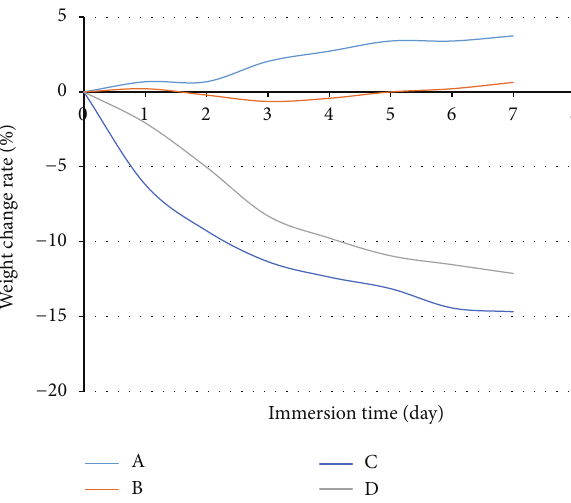
Figure 5: Relationship between weight change rate and immersion time for different coating in